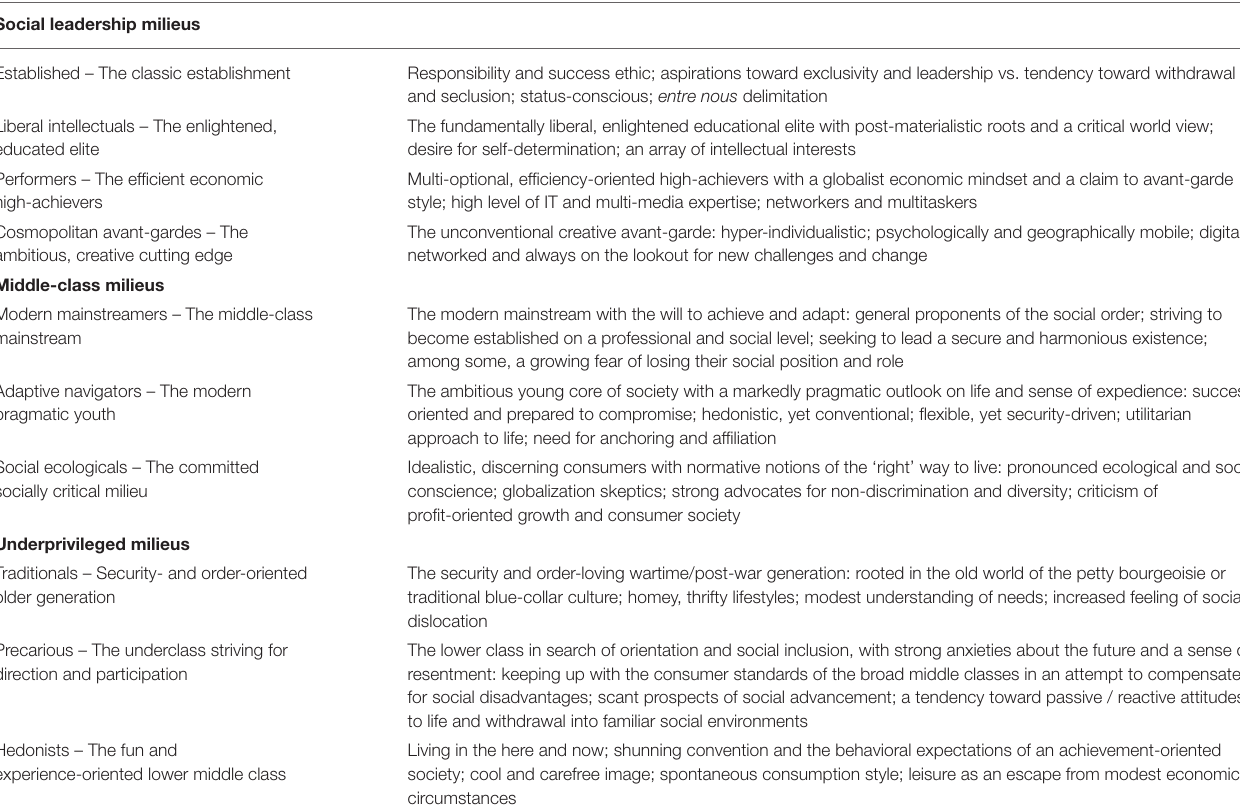
TABLE 1 | Short profiles of the Sinus